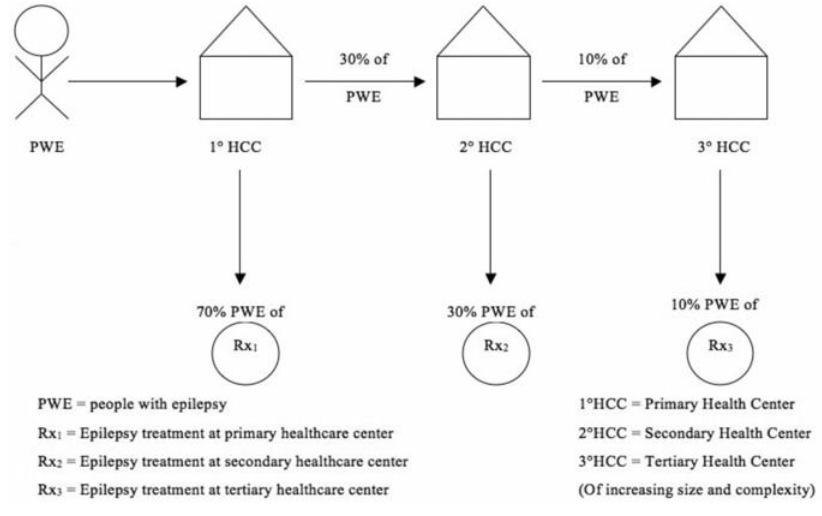
Figure 1. Flow of patients through proposed health